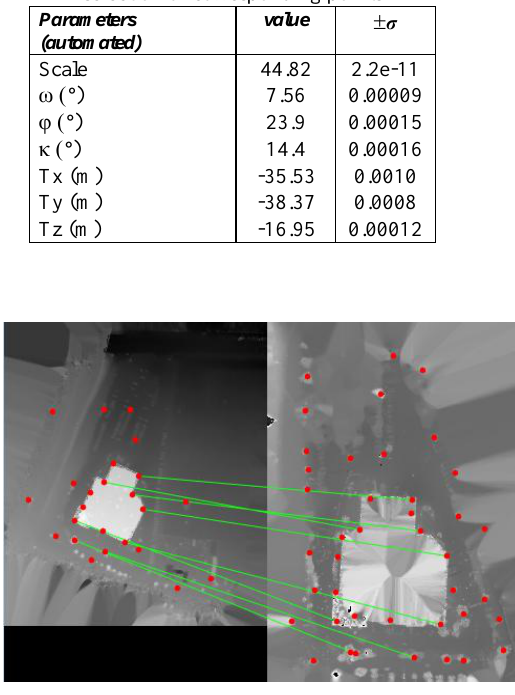
Table 3. Transformation parameters –Automated